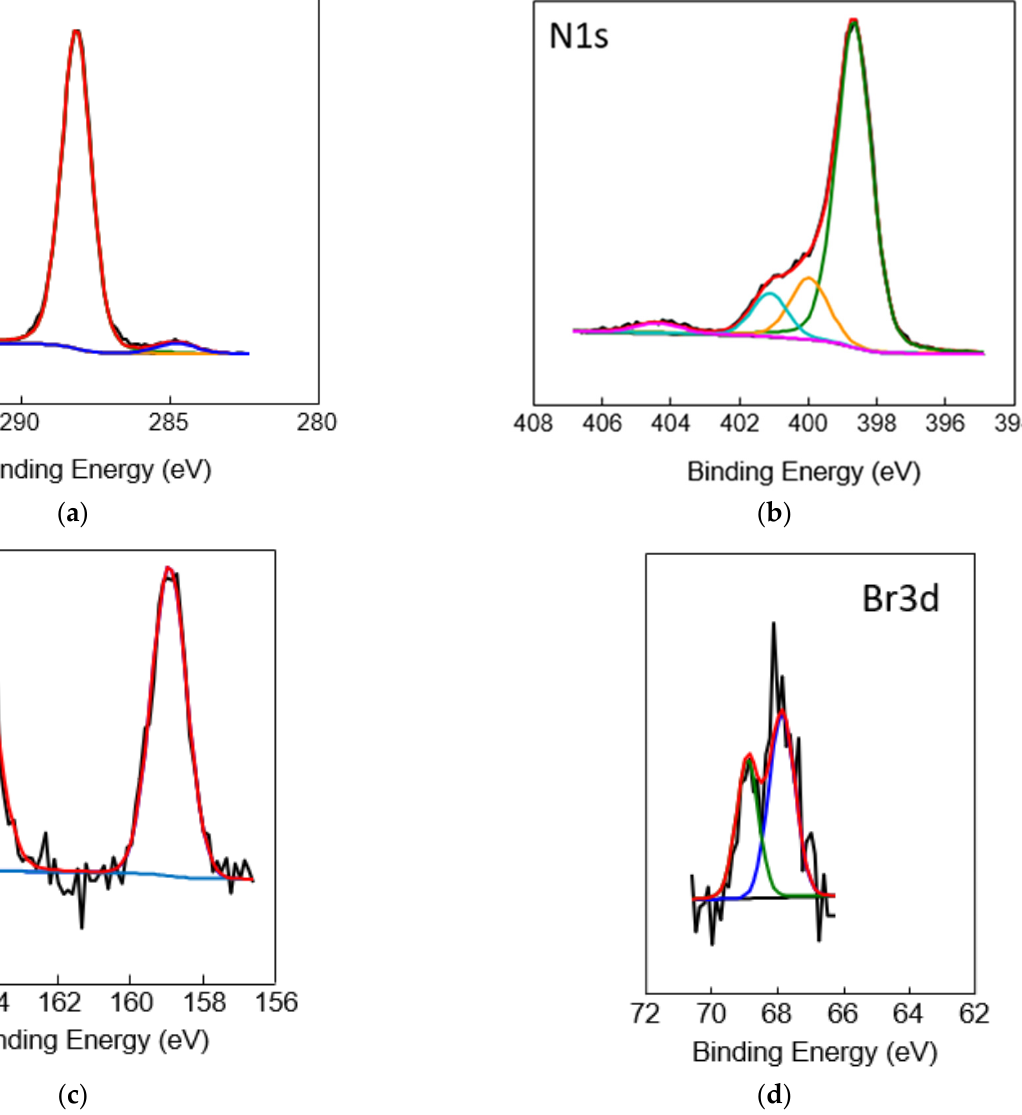
Figure 4. XPS analysis of the 0.02 wt. % Cs 3 Bi 2 Br 9 NCs/g ‐ C 3 N 4 showing the high ‐ resolution spectra of the ( a ) C 1 s , ( b ) N 1s, ( c ) Br 3d and ( d ) Bi 4f. The black line corresponds to the obtained spectrum, the red line to the envelope ‐ fitting curve and the remaining ‐ coloured lines correspond to the fitted peaks.